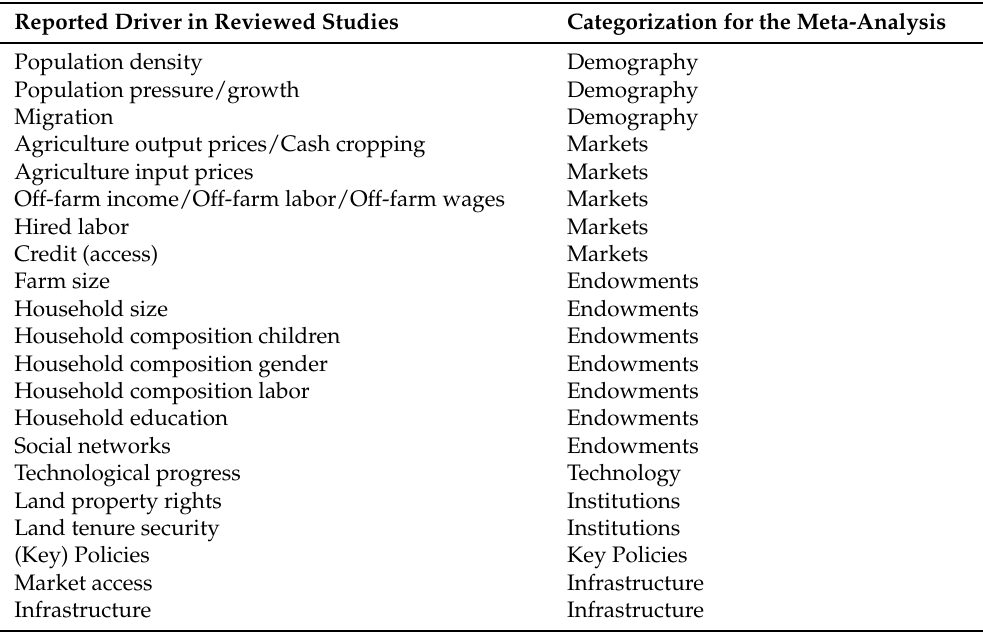
Table A2. Coding of reported land-use change drivers.